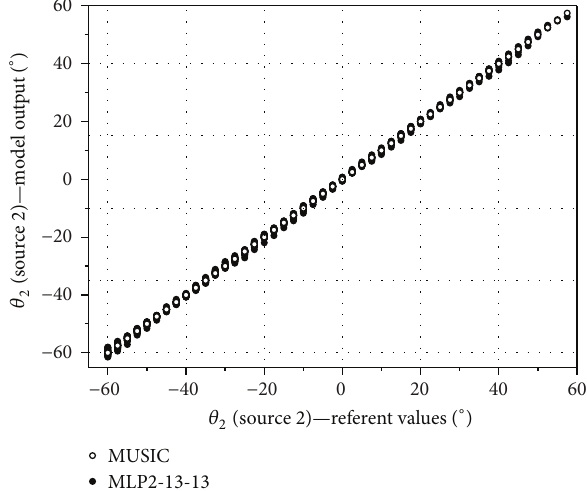
Figure 7: Scattering diagram of chosen MLP-DoA 2 network (MLP2-13-13) and the MUSIC model for output 2 (source 2) obtained by simulation on the test set (Case 𝑠 = 2 ).